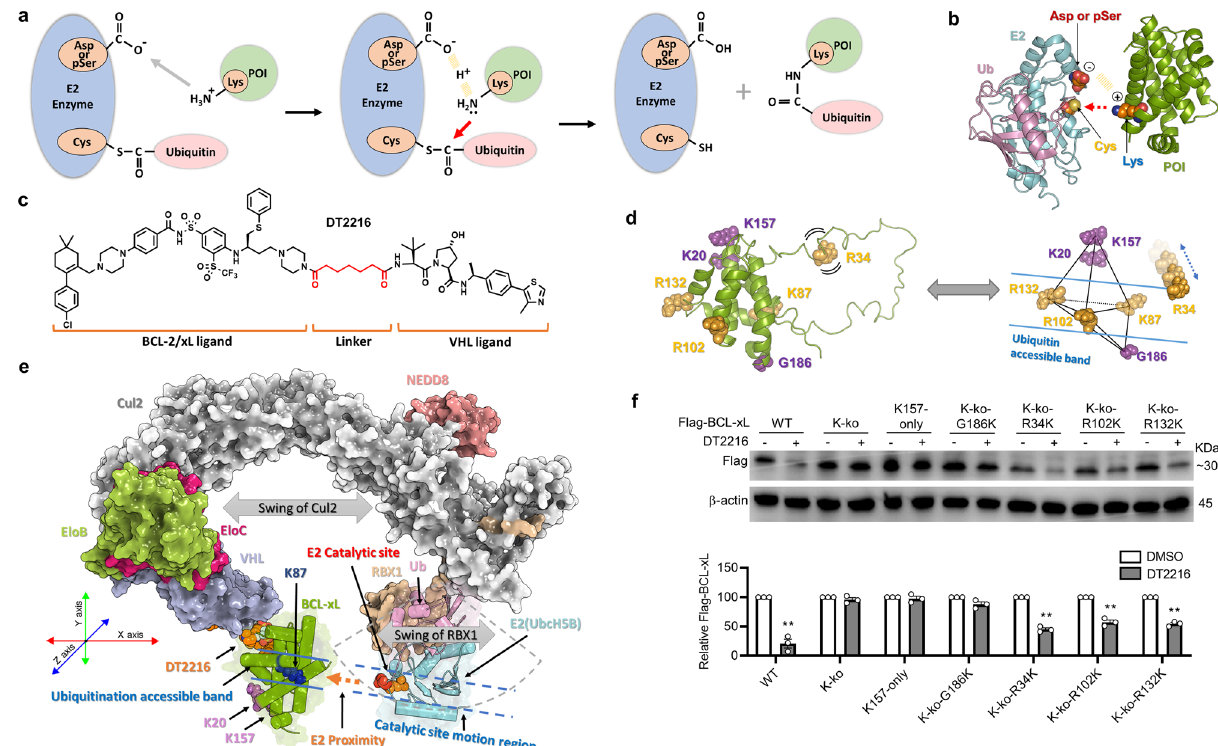
Fig. 1 A band region of accessible lysines on BCL-xL. a A theoretical model of ubiquitination reaction. The protein of interest (POI), ubiquitin, and E2 enzyme are colored in green, pink, and blue, respectively. The conserved E2 serine/aspartate (CES/D) site, catalytic cysteine, and target lysine are showed in orange balls. The target lysine is fi rstly attracted to the CES/D site by electrostatic interaction, and subsequently attack the thioester bond between ubiquitin and E2 enzyme. b Atomic details of the catalytic mechanism. c The structure of DT2216. d A predicted band region of E2-accessible lysines on BCL-xL. The six selected lysine residues or lysine point mutation sites around BCL-xL are shown in sphere style. R34K, R102K, R132K, and K87 are in the predicted band region, and K20, K157, and G186K are outside of the band region. e A computational model of the entire CRL VHL /DT2216/BCL-xL/E2-Ub/ RBX1 complex. The possible motion region of E2 is shown with dashed sector. The catalytic site motion region is represented by two blue dashed lines. The accessible region of the ubiquitination is represented by the two blue lines along the direction of E2 proximity to POI represented by an orange dashed arrow. The potential direction of swing of Cul2 and RBX1 are shown by a gray double-headed arrow. f The point mutation analyses con fi rm the existence of a band region of lysines on BCL-xL. WT: wild type Flag-BCL-xL; K-ko: all the surface lysines on BCL-xL are mutated to arginines; K157-only: all the surface lysines on BCL-xL are mutated to arginines except K157; K-ko-G186K, K-ko-R34K, K-ko-R102K, and K-ko-R132K represent that all the surface lysines on BCL-xL are mutated to arginines and then Gly186, Arg34, Arg102, and Arg132 are respectively mutated to lysine. β -actin was used as an equal loading control. The quanti fi cation of the relative Flag-BCL-xL protein content in the immunoblots is presented as mean values ± s.e.m. ( n = 3 biologically independent experiments) in the bar graph (bottom panel). Statistical signi fi cance was calculated with unpaired two-tailed Student ’ s t -tests comparing DMSO- to DT2216-treated samples. ** P < 0.01; P values were 0.0089, 0.0023, 0.0077, and 0.0026 for WT, K-ko-R34K, K-ko-R102K, and K-ko-R132K, respectively. Source data are provided as a Source data fi